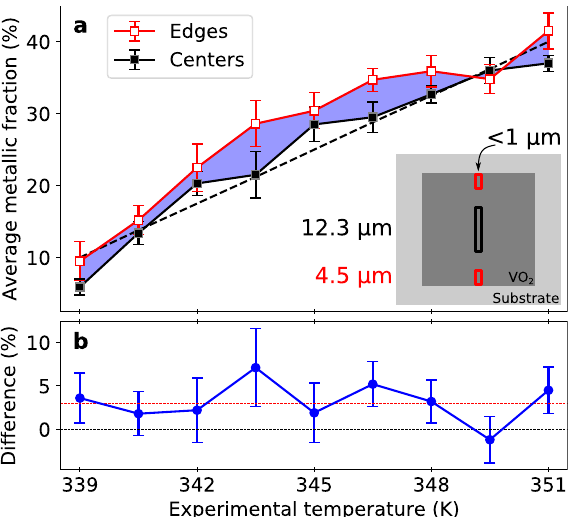
Figure 3. Comparison of average metallic fraction of center (black filled squares) and edge (red empty squares) regions of VO 2 microsquares for experimental temperatures around the transition temperature T t . Each data point in panel ( a ) is the average of seven metallic fractions, determined from different energies in the X-ray absorption spectrum (see Fig. 2). Error bars represent the standard deviation of those seven values. The dashed black line is a guide to the eye and represents a perfectly linear increase of the metallic fraction with experimental temperature. The inset visualizes the regions of interest (ROIs) on a VO 2 square from which the signal for respective data color was extracted. In horizontal direction the dimensions of the ROIs are determined by the width of the vertical X-ray line focus. In the vertical, the ROI dimensions are chosen. The blue shaded area shows the difference in metallic fractions of center and edge regions, which is additionally plotted in panel ( b ). The black and red horizontal line in b are a guide to the eye at difference values of 0% and